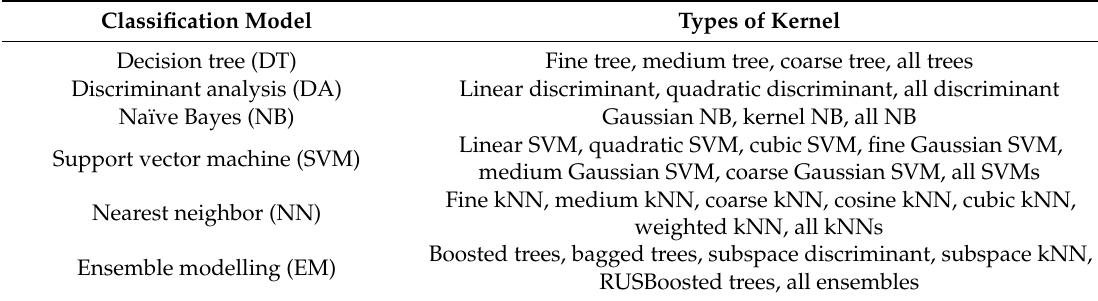
Table 2. List of classification models and